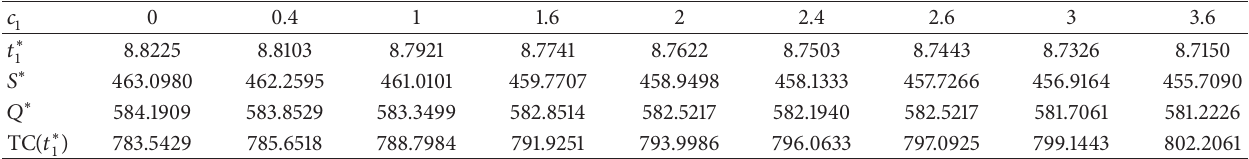
Table 4: The sensitivity of 𝑐 1 for the models in Example 1.